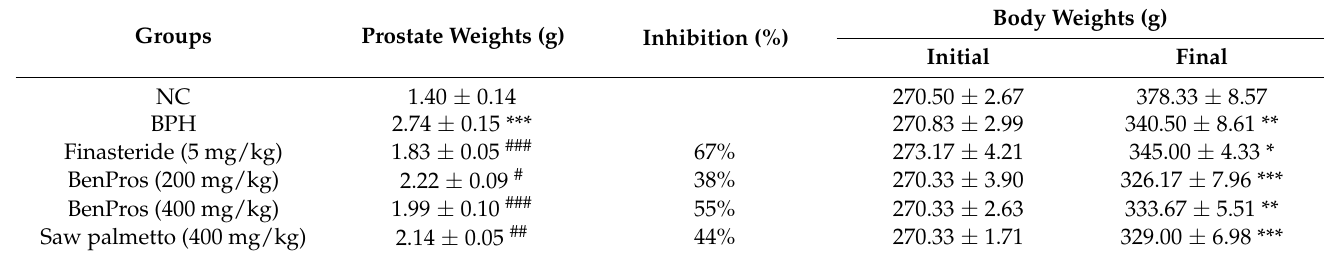
Table 1. Prostate growth inhibition ratio in each group.